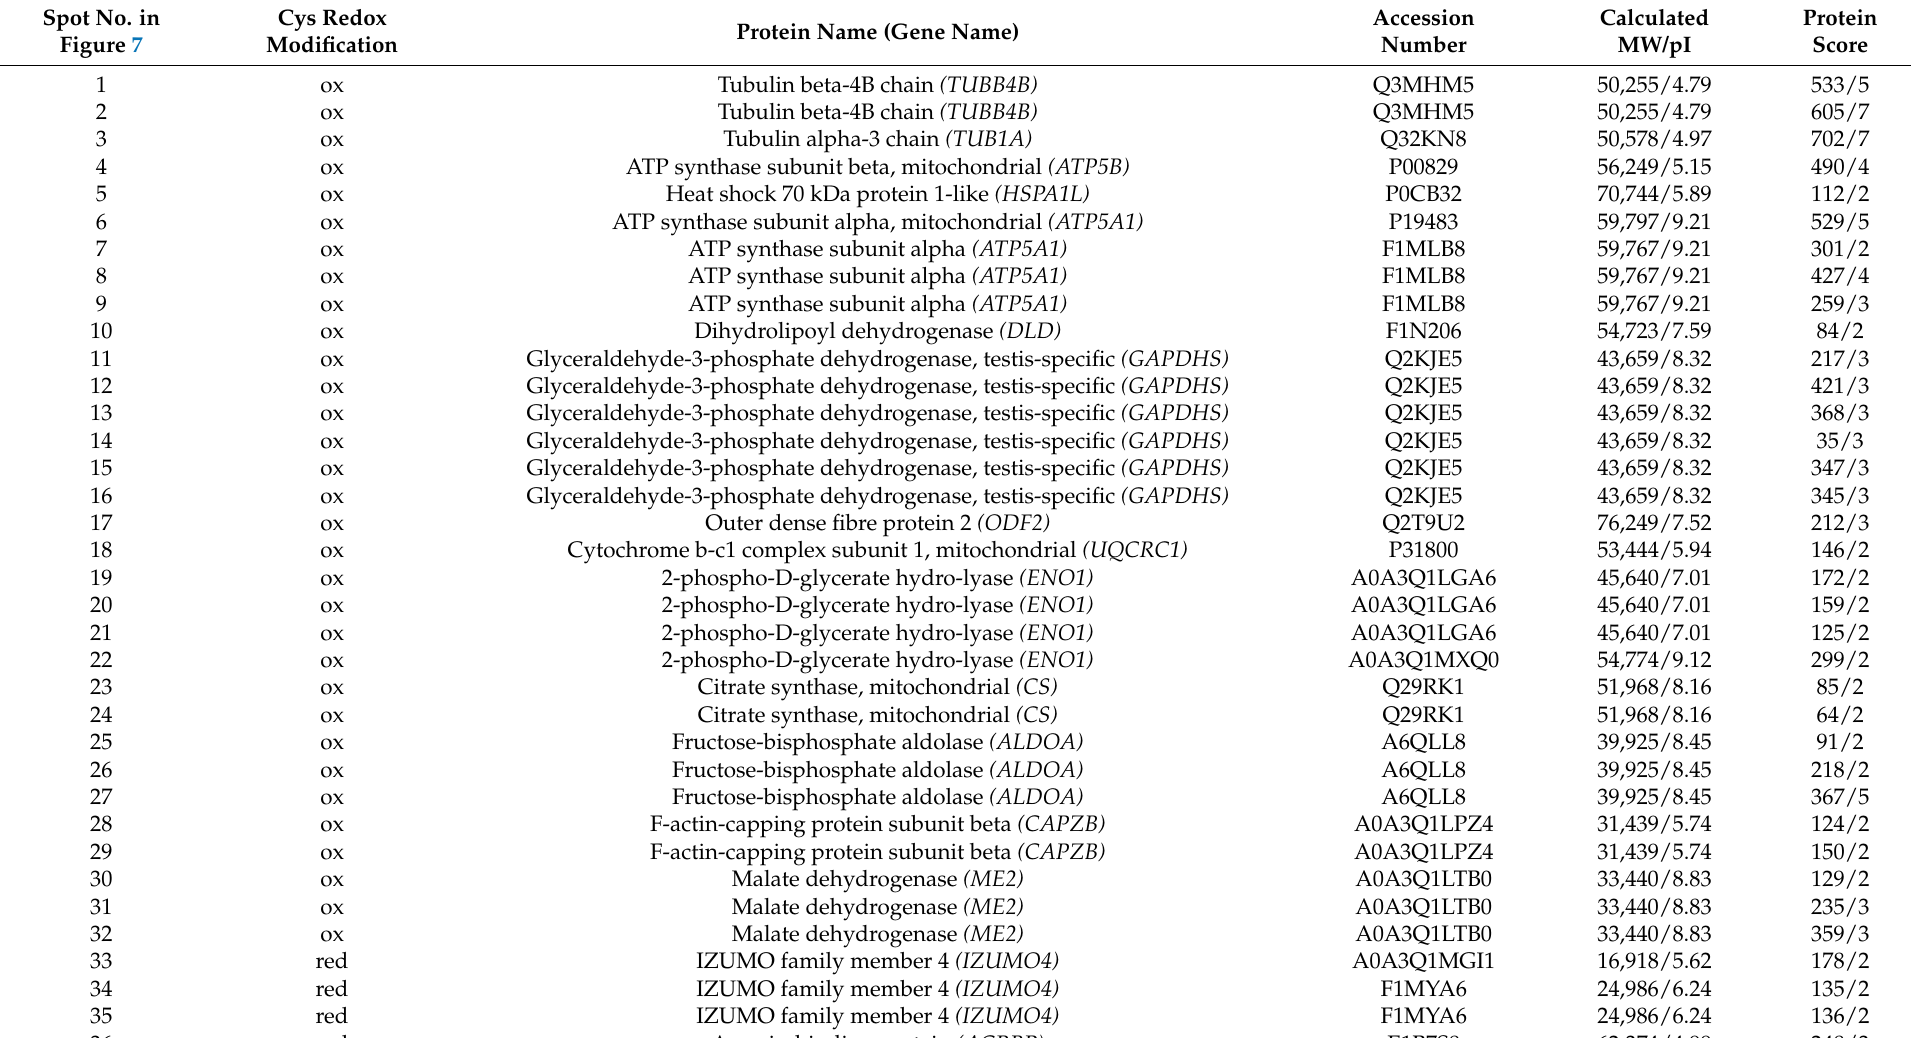
Table 1. Proteins showing changes in oxPTM levels after 6 h of incubation in capacitation-supporting conditions; oxidised (ox) or reduced (red) cysteines ( n = 8 in each group; p < 0.05). Spot No.